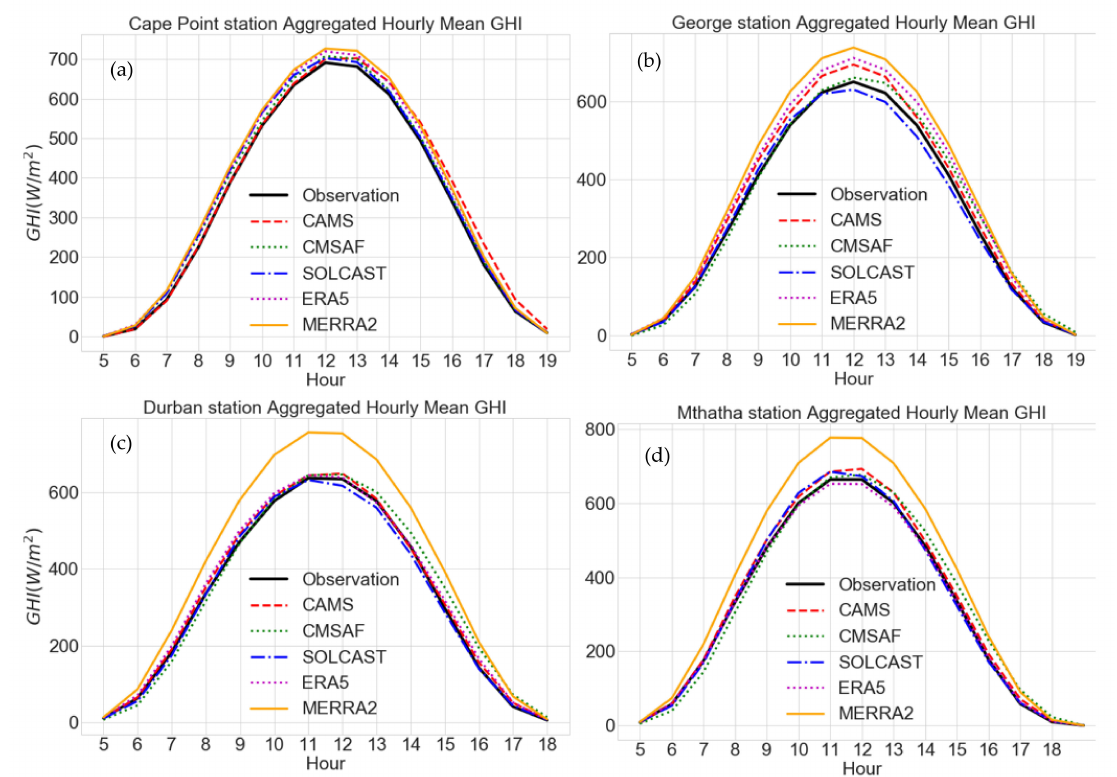
Figure 8. Aggregated measured and estimated hourly GHI values in values in Cape Point ( a ), George ( b ), Durban ( c ), and Mthatha ( d ). The aggregated GHI Observation period for each station is given in Table